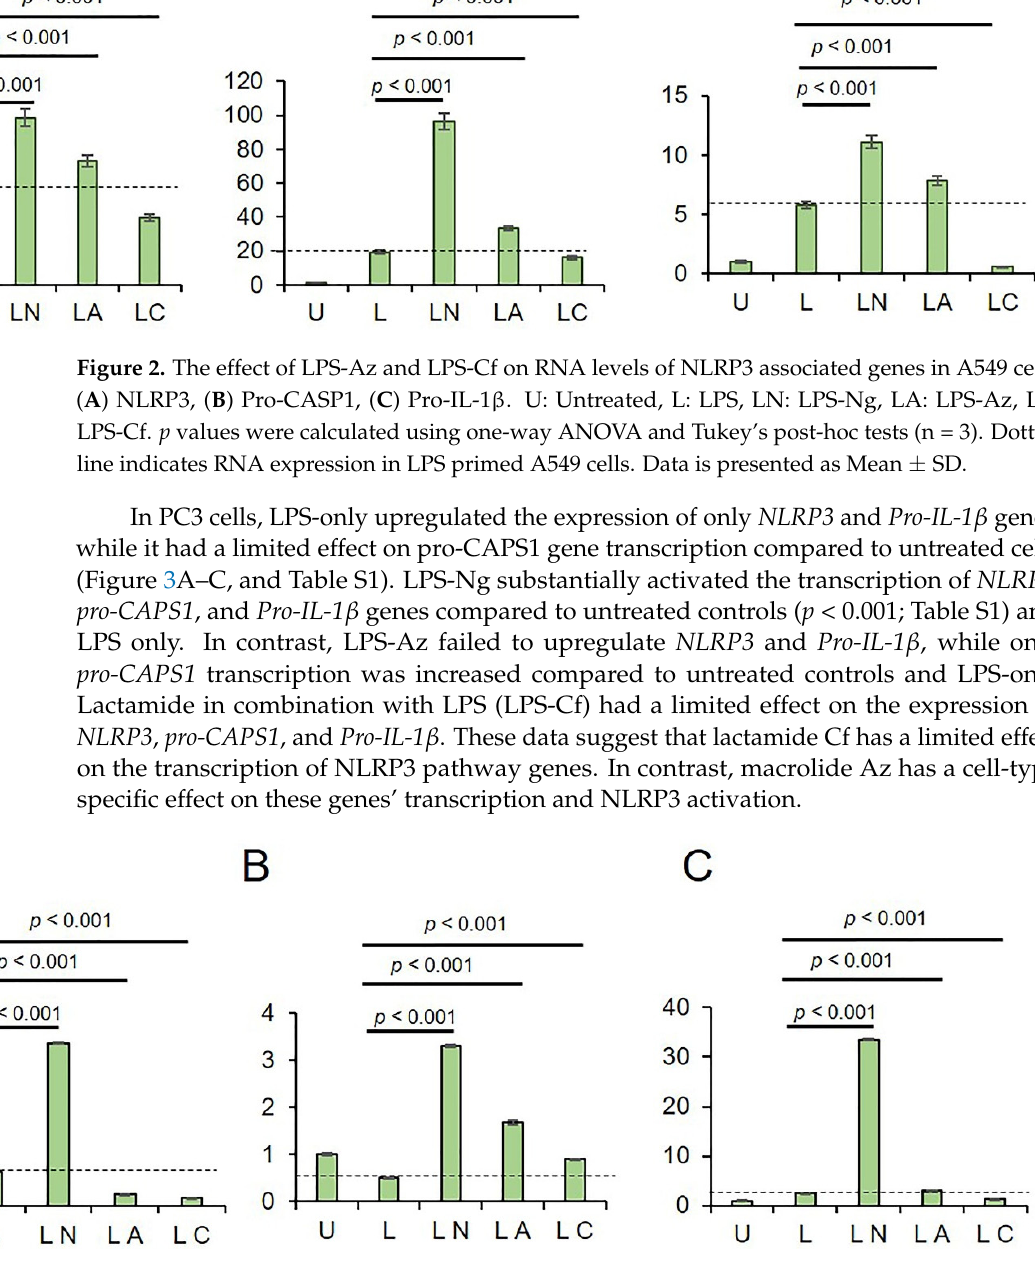
Figure 3. The effect of LPS-Az and LPS-Cf on RNA levels of NLRP3 associated genes in PC3 cells. ( A ) NLRP3, ( B ) Pro-CASP1, ( C ) Pro-IL-1 β . U: Untreated, L: LPS, LN: LPS-Ng, LA: LPS-Az, LC: LPS-Cf. p values were calculated using one-way ANOVA and Tukey's post-hoc tests (n = 3). Dotted line indicates RNA expression in LPS primed PC3 cells. Data is presented as Mean ± SD.